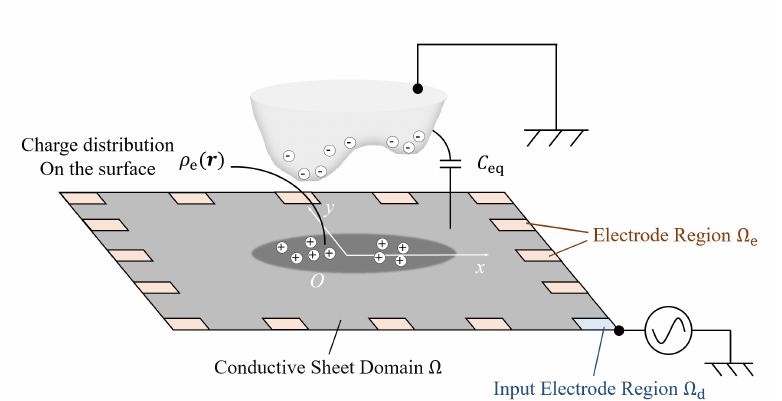
Figure 1. Overview of the proximity imaging. The system interprets physical distance information as voltage data on electrodes and then uses an inverse problem solver to map capacitance density (modified from the work in [21]).